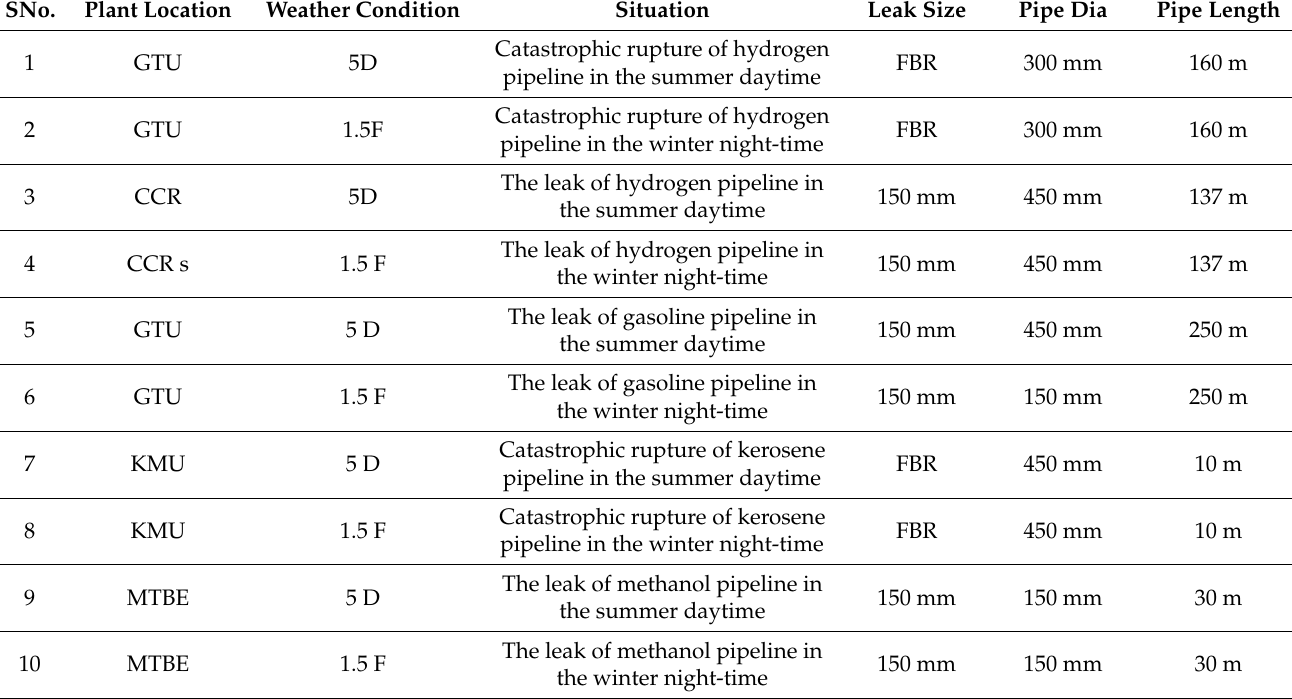
Table 1. The list of worst-case hazardous